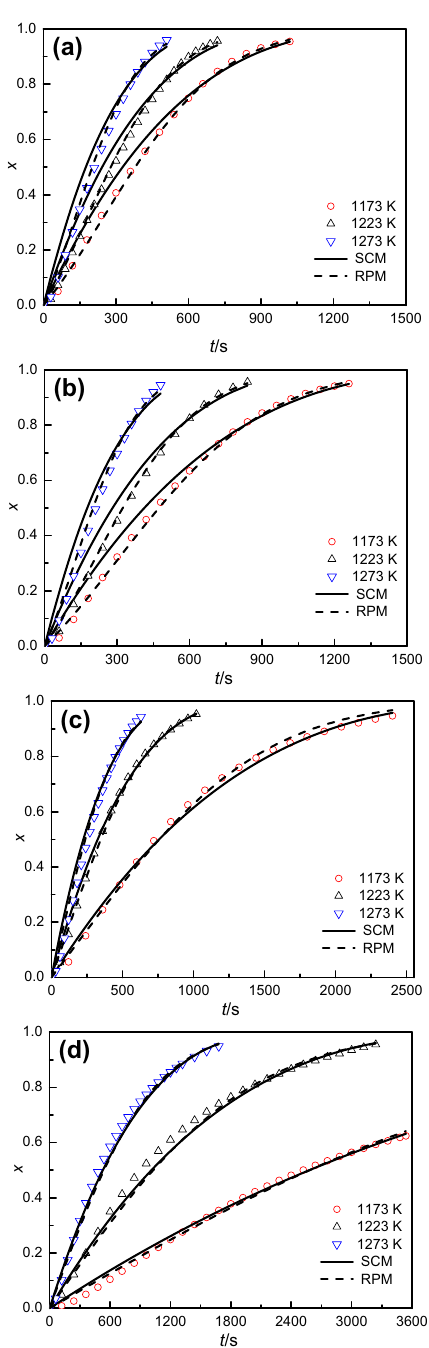
Fig. 5 Comparison of RPM-and SCM-predicted conversions to experimental values: a Py1073 char; b Py1173 char; c Py1273 char; and d MW